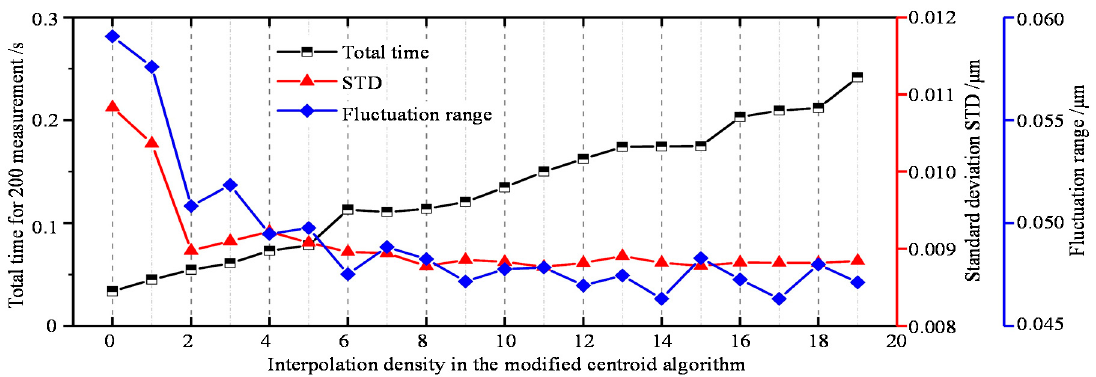
ff erent interpolation